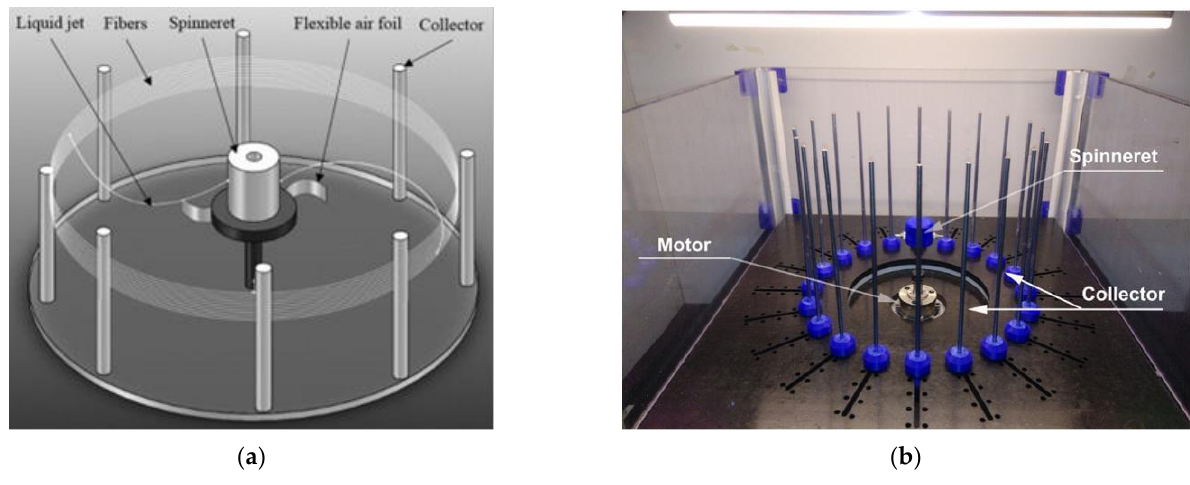
Figure 1. Schematic diagram of ( a ) centrifugal spinning (Reprinted with permission from Ref. [18]. 2013 Elsevier) and ( b ) the equipment (Reprinted with permission from Ref. [14]. 2016 Elsevier).